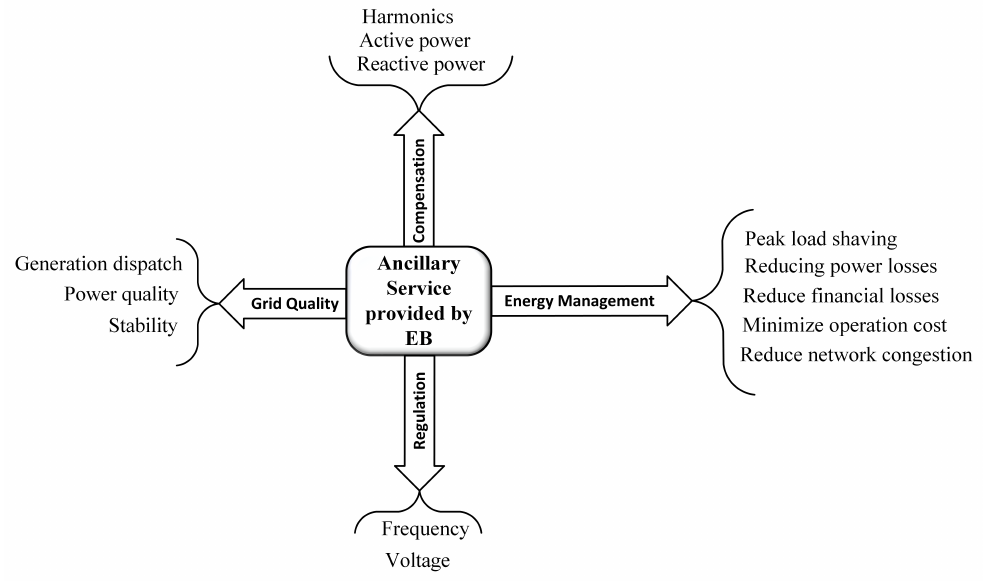
Figure 7. Ancillary services provided by